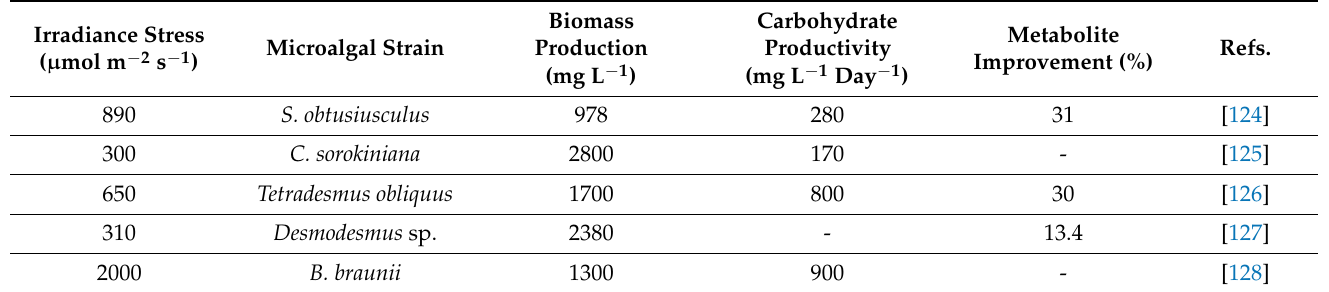
Table 3. Effects of different radiations on microalgae biomass and carbohydrate production, with metabolite improvement